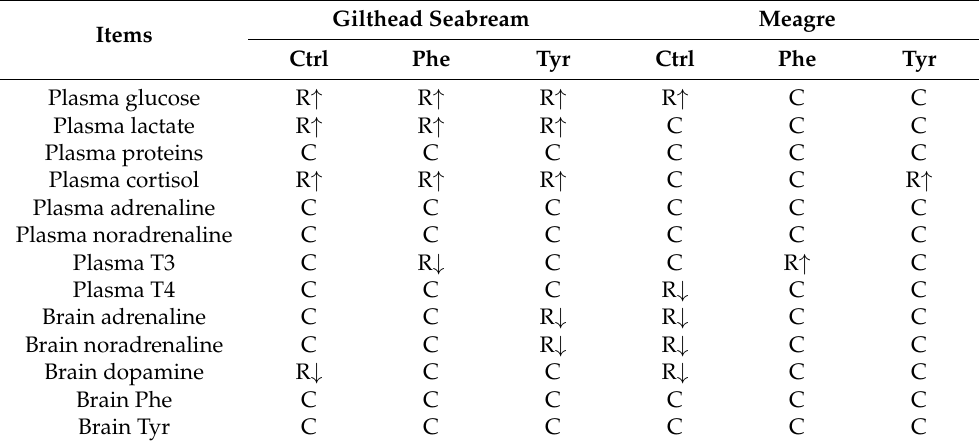
Table 1. Different types of stress response for each stress marker analyzed in the plasma and brain of gilthead seabream ( Sparus aurata ) and meagre ( Argyrosomus regius ) in the basal and stressed states. Fish were fed control diets (Ctrl) or diets supplemented with phenylalanine (Phe) or tyrosine (Tyr). C: no significant differences between baseline and stress states; R ↑ /R ↓ : increasing/decreasing